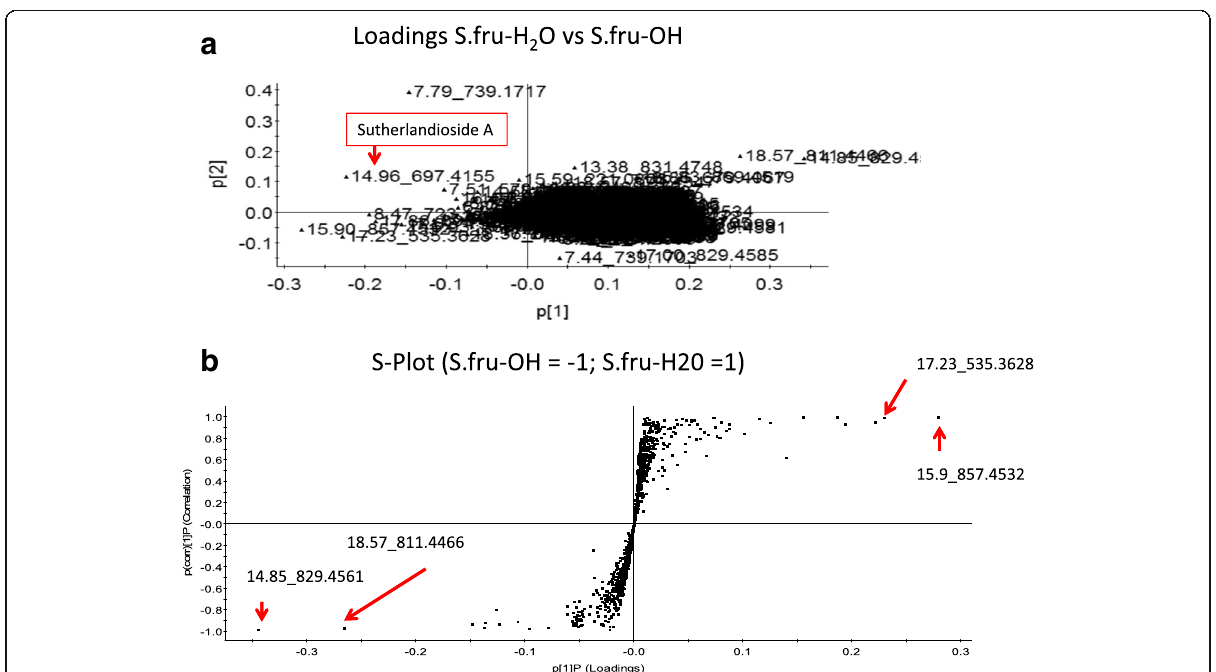
Fig. 5 a Loadings plots based on PCA separation of S.fru-OH extract and S.fru-H 2 O. b S-Plot of the PLS-DA method used to study the S.fru-OH [= − 1] and S.fru-H 2 O [=1] extracts of S.